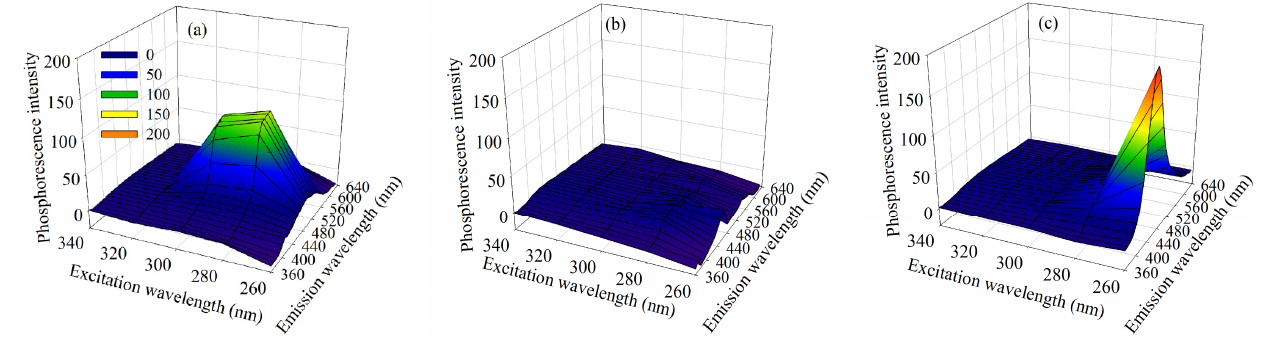
Figure 3. Excitation–emission matrix phosphorescence corresponding to samples of ( a ) a 3.80 μ g mL − 1 FLU sample, ( b ) a free-interference water sample, and ( c ) a wastewater one. FLU sample, ( b ) a free-interference water sample, and ( c ) a wastewater